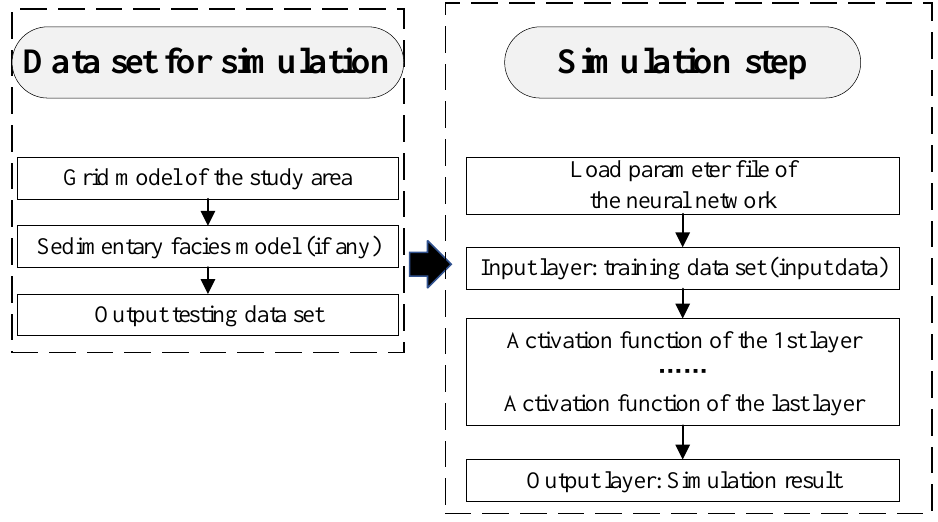
Figure 2. Flow chart of the DFNN simulation process for 3D reservoir geological modeling.